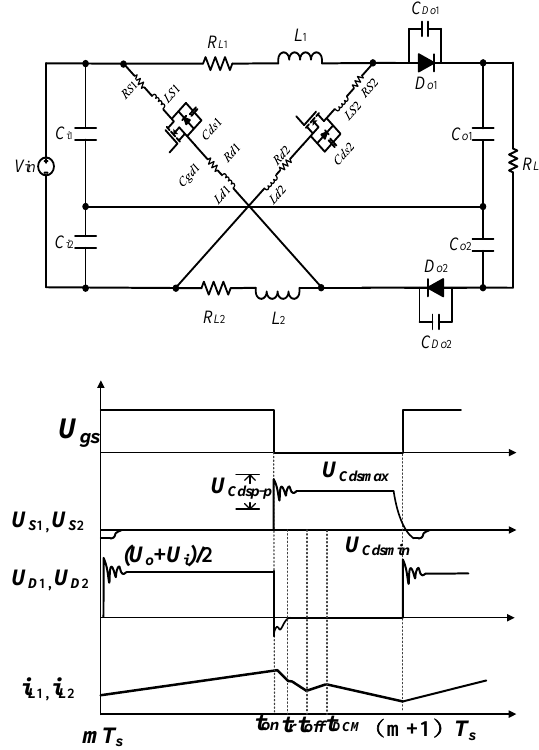
Figure 2. Dual switch step-up DC / DC converter considering parasitic parameters.